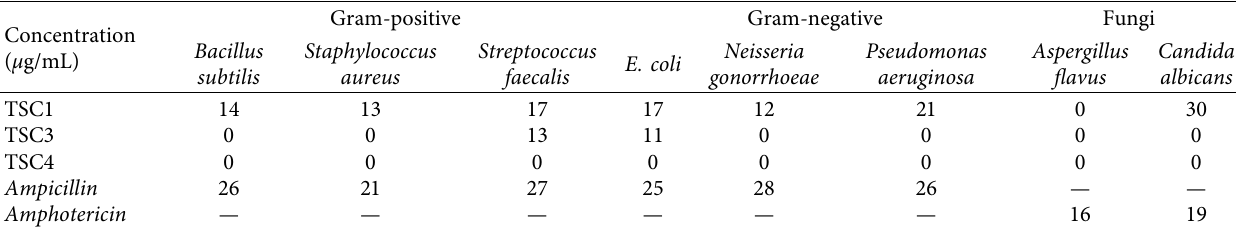
Table 3: Antibacterial and antifungal activities of the synthesized thiosemicarbazone compounds. Concentration ( μ g/mL)